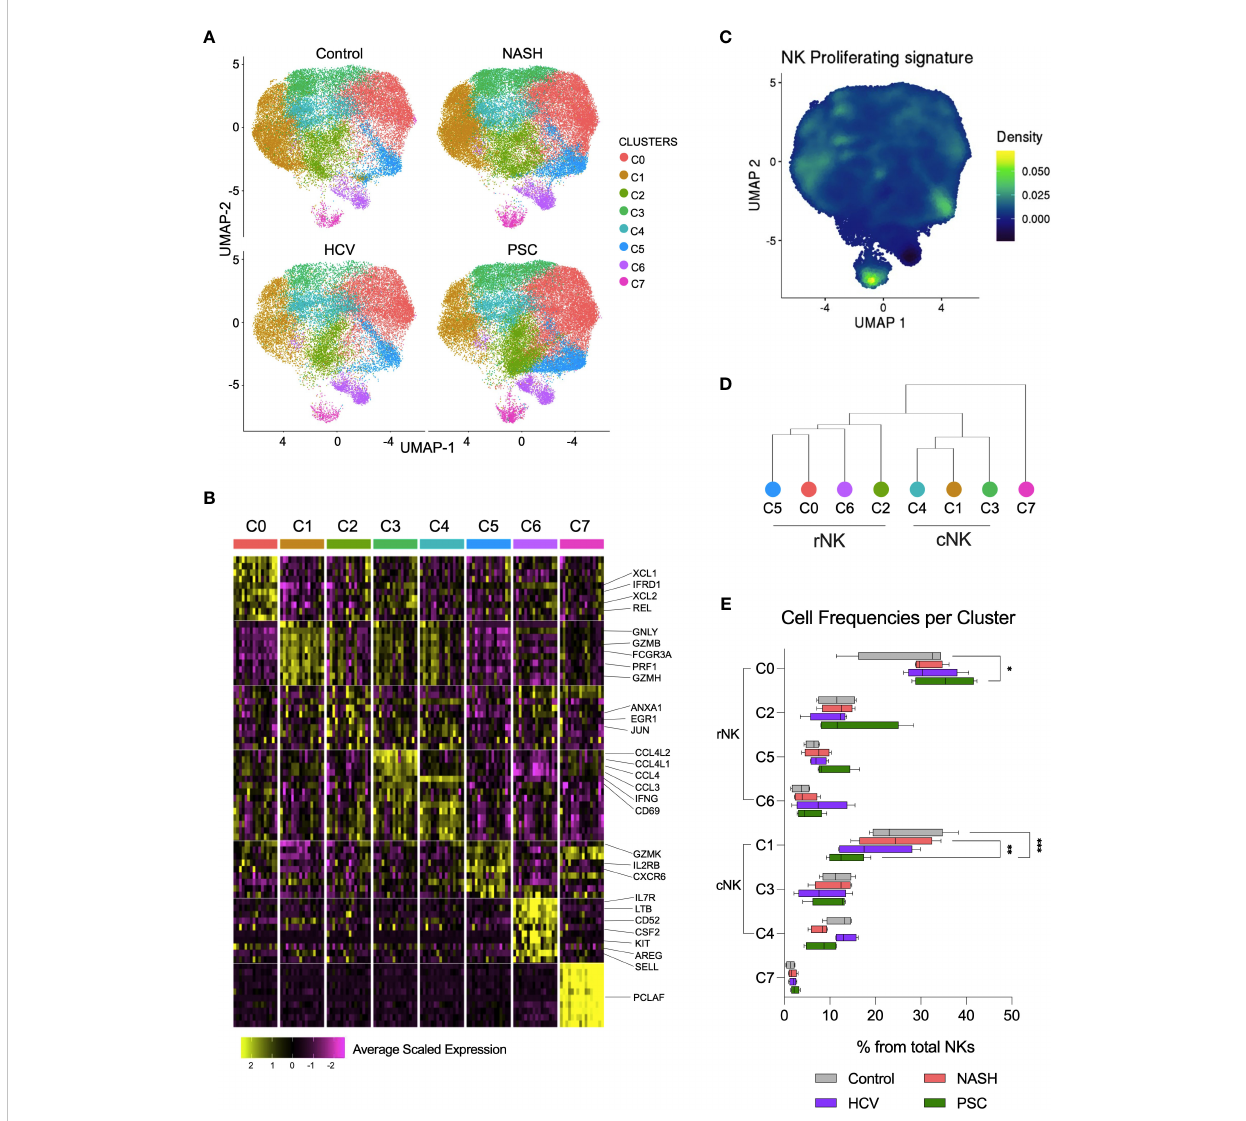
FIGURE 6 Single-cell RNAseq revealed eight subsets of hepatic NK cell in end-stage liver diseases. (A) UMPAs showing He-NK cells clusters in healthy, NASH, HCV, and PSC livers. (B) The main transcriptomic markers observed in each cluster indicated that clusters C0, C2, C5 and C6 are rNK cells, clusters C1, C3 and C4 are cNK cells and C7 displays features of cycling NK cells. (C) Dendrogram showing the relationships of NK cell clusters. (D) The analysis of cell frequencies per cluster showed signi fi cant variation of cells in clusters C0 and C1. *P-value < 0.05; **P-value < 0.01; ***P-value <